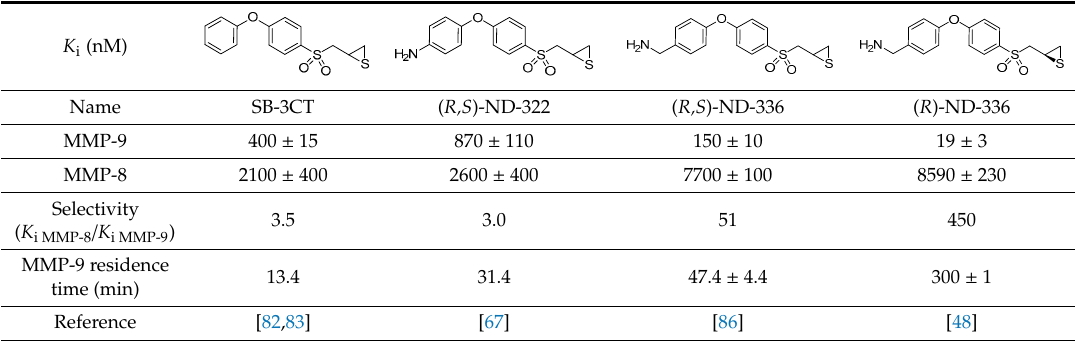
Table 2. Inhibition constants for the small-molecule inhibitors, showing the progression to selectivity.